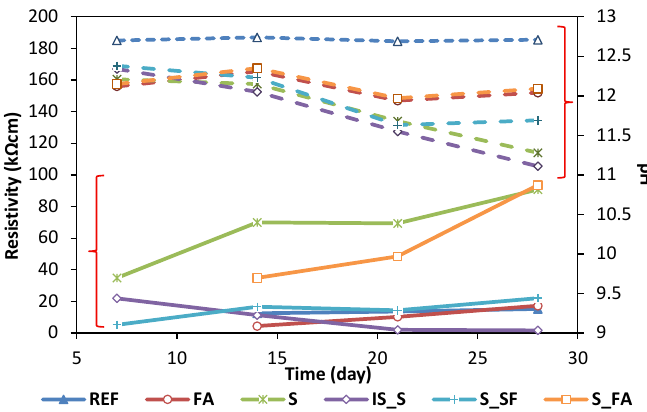
Figure 4. Evolution of the surface resistivity (continue line) and pH of the leaching solution (dotted line).